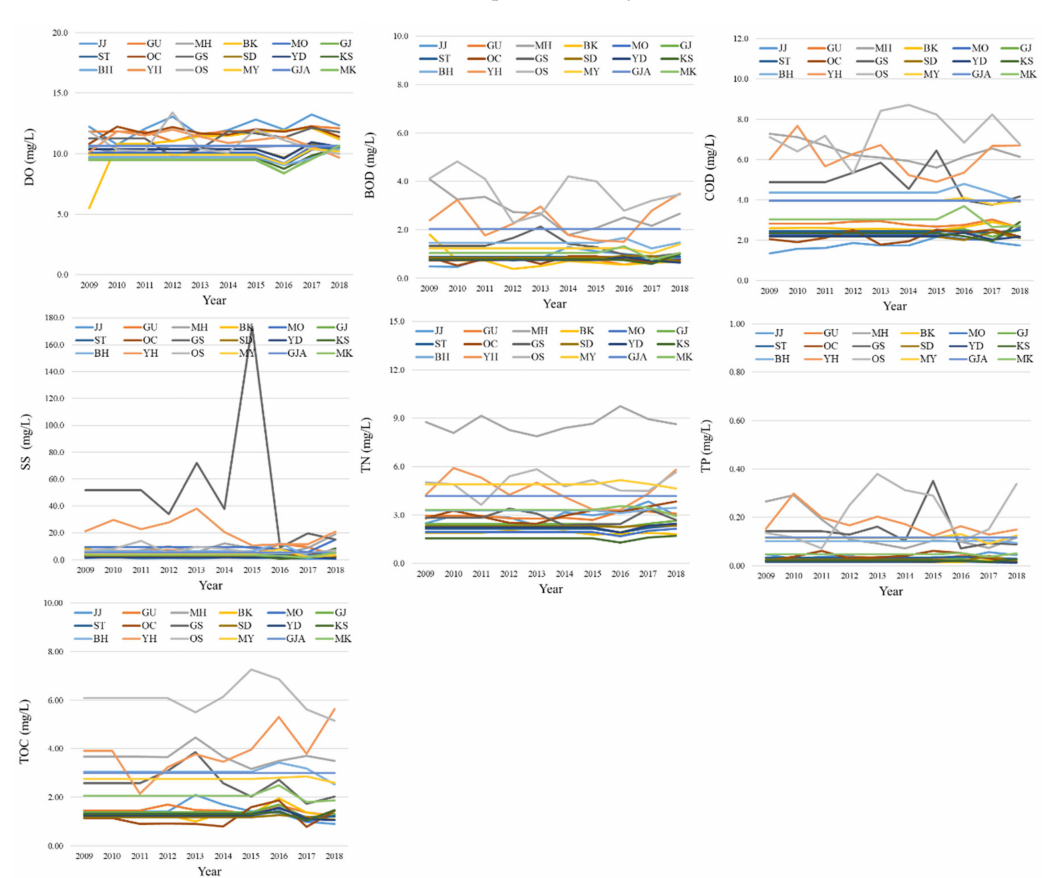
Figure 6. Variation of annual water quality during the study